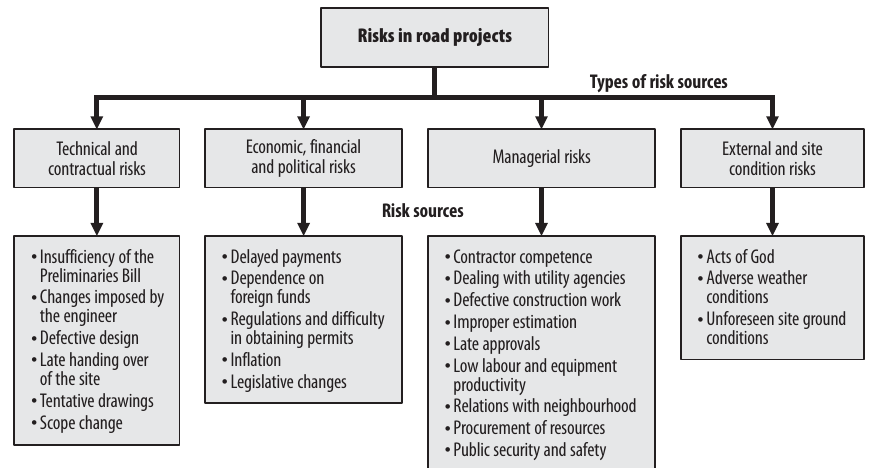
Figure 1. Risk classifi cation